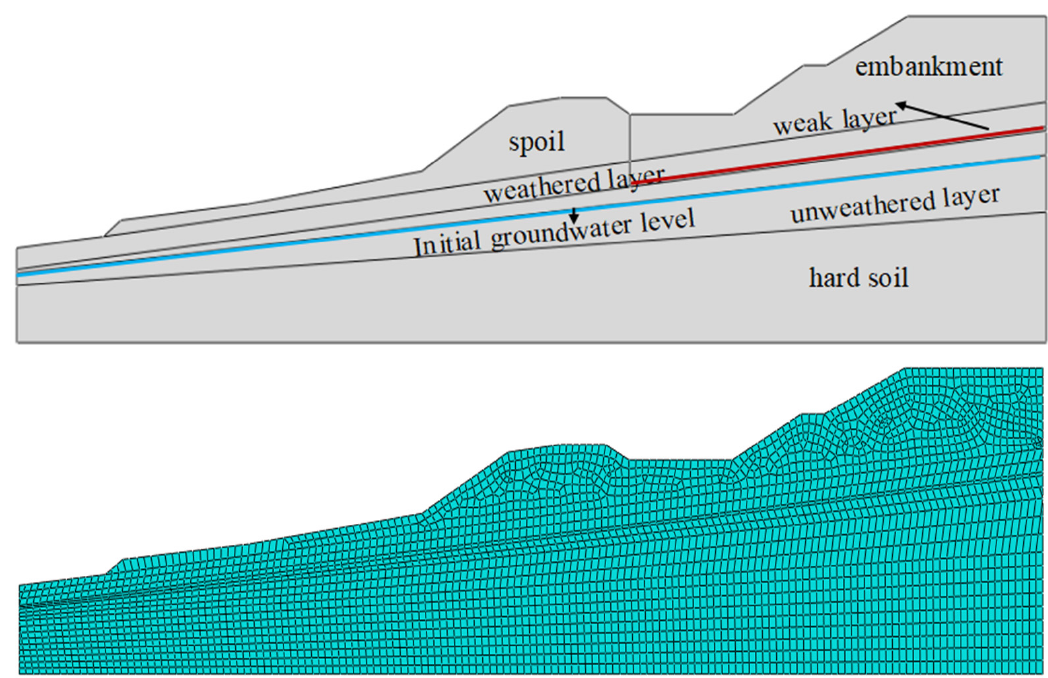
Figure 4. Basic model of slope.